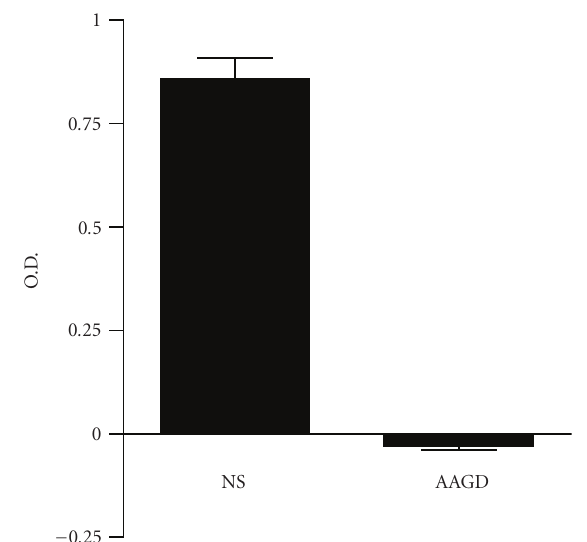
Figure 5: Comparison between normal skin (NS) and alloplastic acellular glycerolized dermis (AAGD) viability. There are no viable cells in the AAGD. The results refer to day